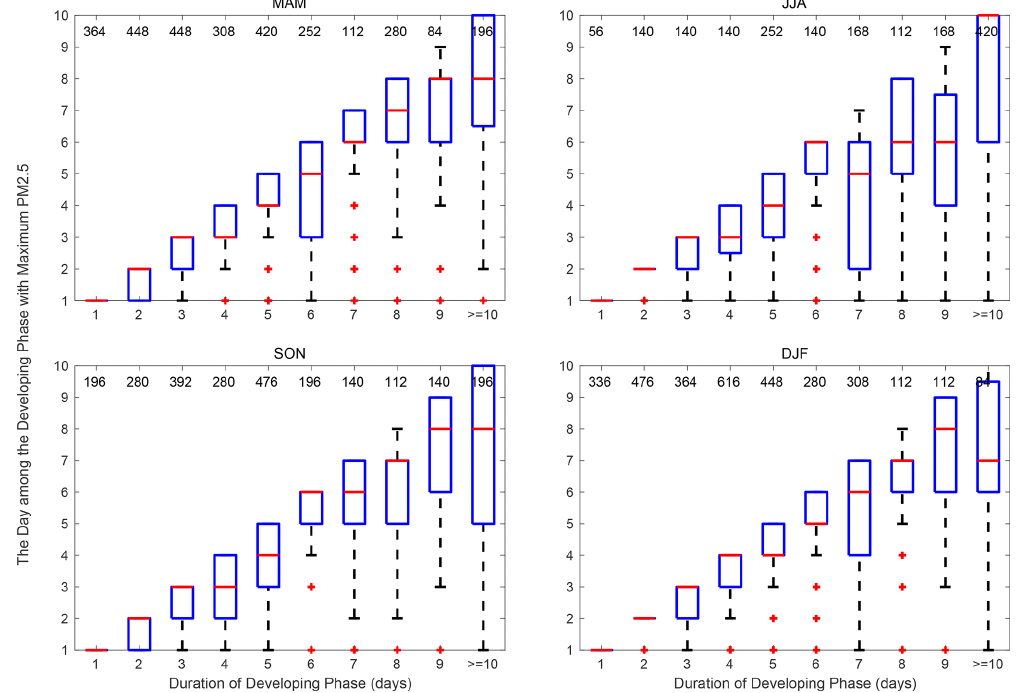
Figure 10. The day of the maximum PM 2 . 5 concentration during each pollution episode varies with the duration of the developing phase.